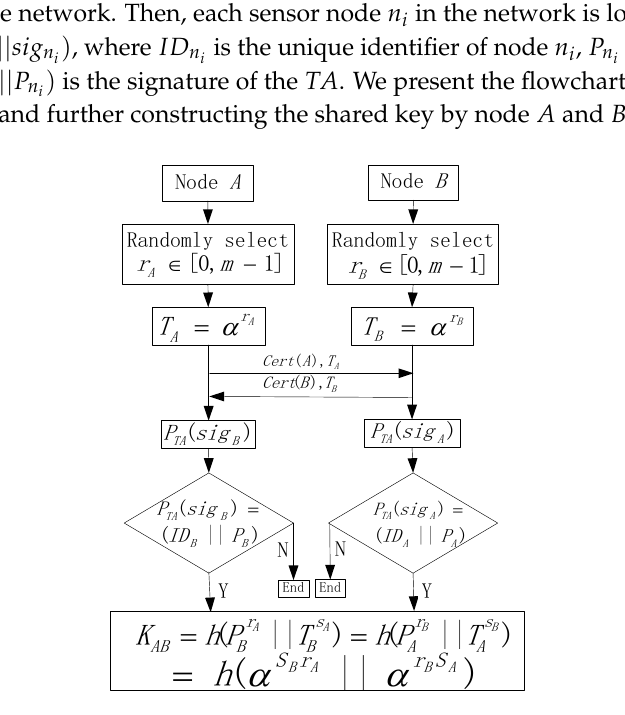
Figure 3. Flowchart of constructing shared keys by node 𝐚 and 𝒃 .